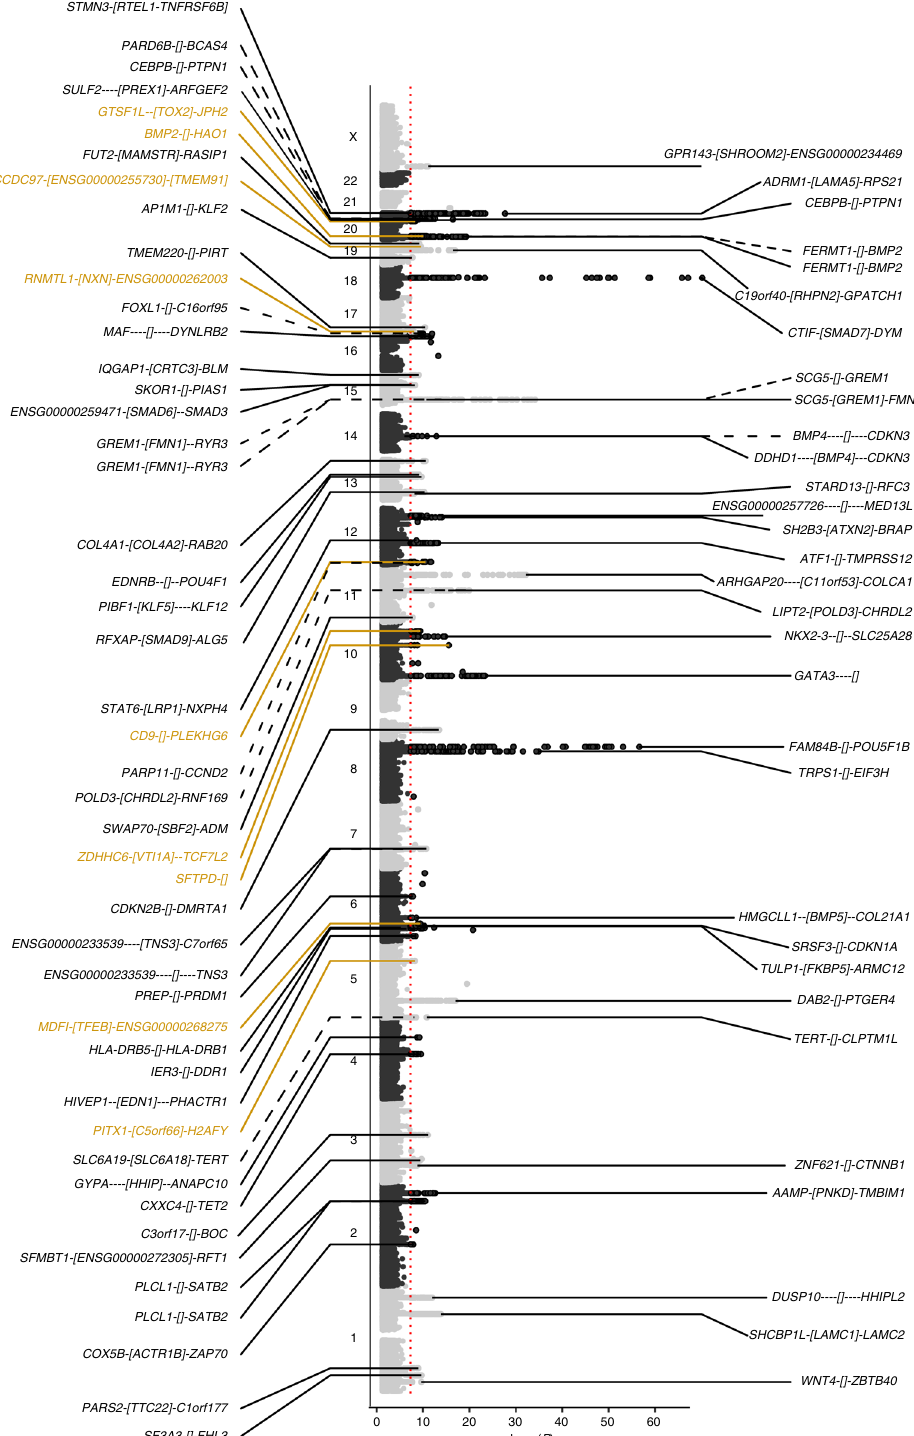
Fig. 2 Manhattan plot showing all loci containing genetic risk variants independently associated with colorectal cancer risk at P < 5 × 10 − 8 in European populations. SNPs on the left of the plot are new SNPs identi fi ed in this study, and SNPs on the right were identi fi ed in previous studies and replicated at genome-wide signi fi cance in this study. The 79 risk SNPs consisted of 31 previously reported SNPs, 39 new risk SNPs, and nine SNPs previously identi fi ed in Asian but not in European populations (denoted in dark gold). Dotted lines indicate SNPs that were identi fi ed as independent through conditional analysis. Square brackets indicate the position of the sentinel SNP relative to nearest genes ( “ gene1-[]-gene2 ” for intergenic SNPs, “ [gene] ” for intragenic SNPs). The distance from the sentinel SNP to each gene is proportional to the number of dashes. The red line indicates the genome-wide signi fi cance threshold. The x -axis represents the − log 10 P -values of the SNPs, and the y-axis represents the chromosomal